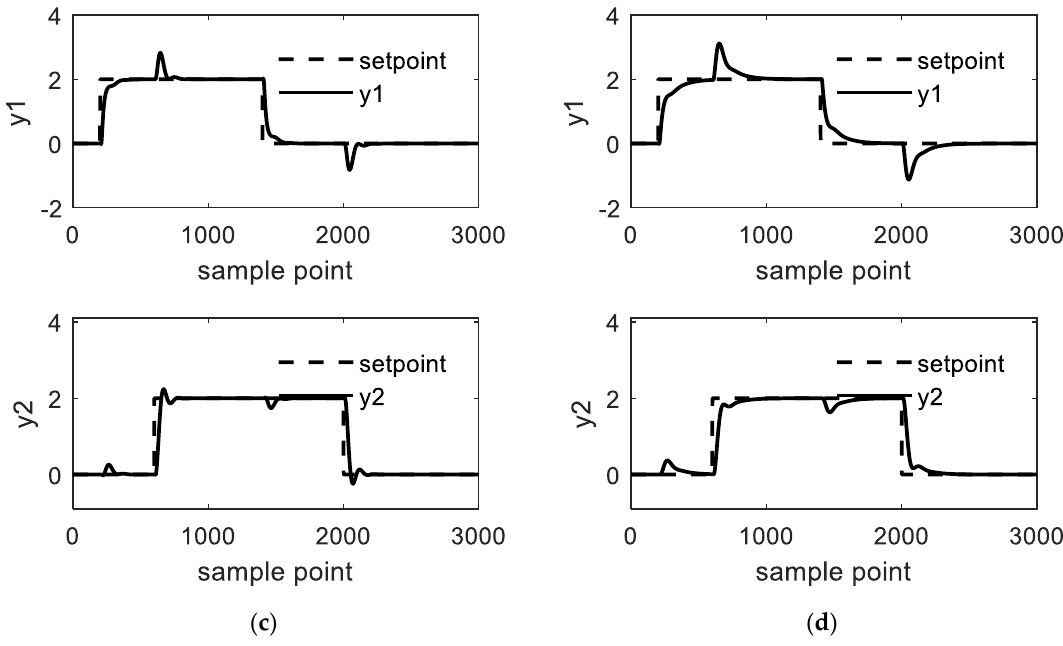
Figure 7. The response of the system without disturbance: ( a ) SMPC; ( b ) SMDP; ( c ) OSMDP1; ( d ) OSMDP2.